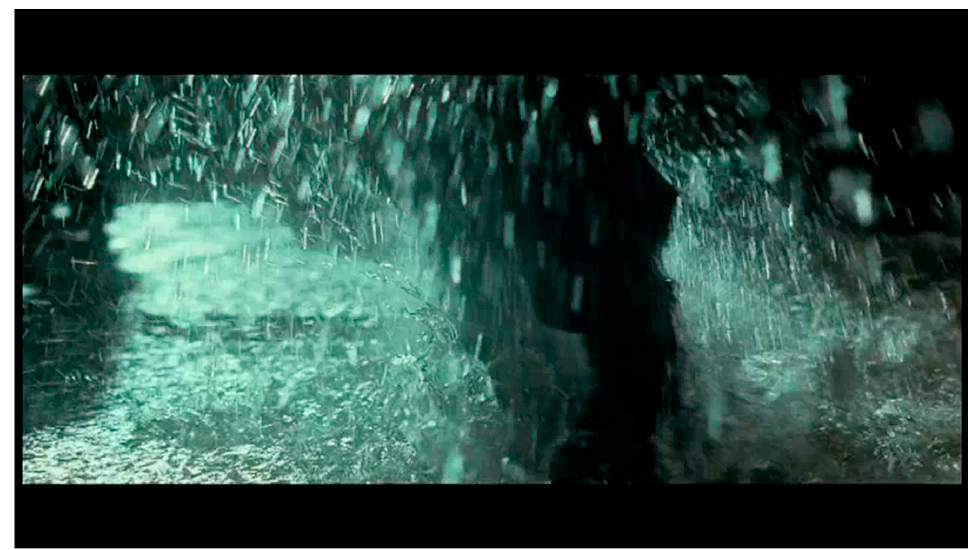
Figure 8. Water punches the ground as the human bodies block, throw, lunge. Frame capture, The Grandmaster (Wong 2013).